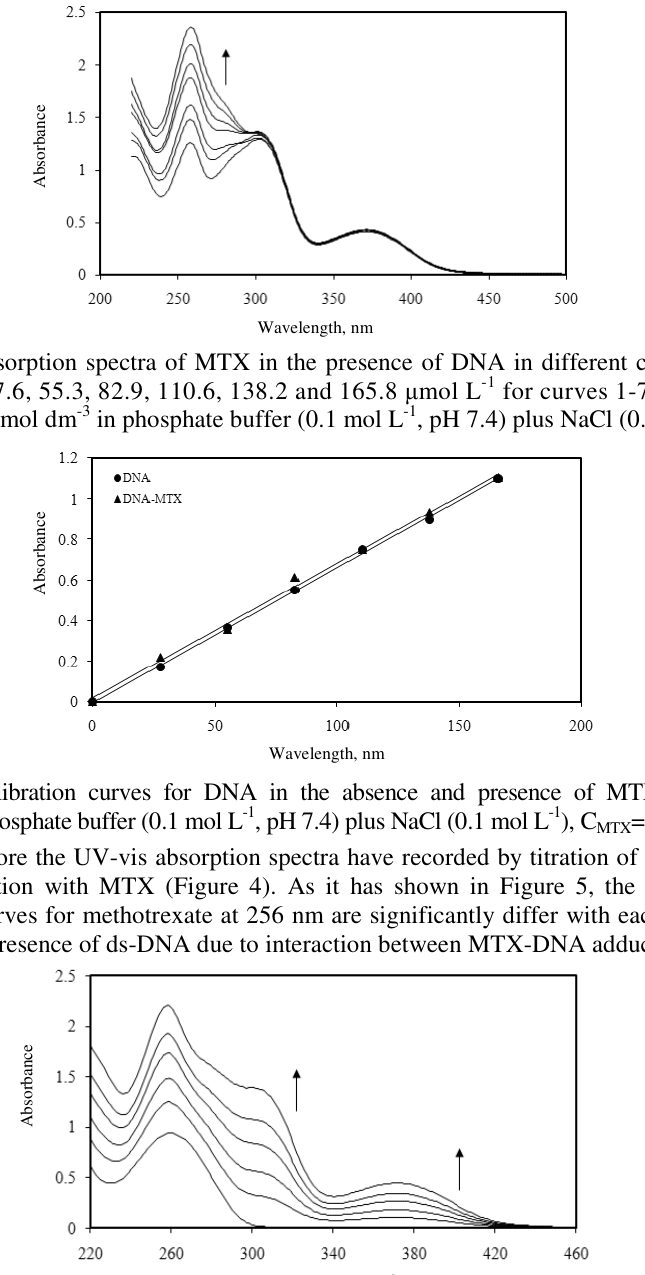
= 50.0 µ mol L -1 DNA